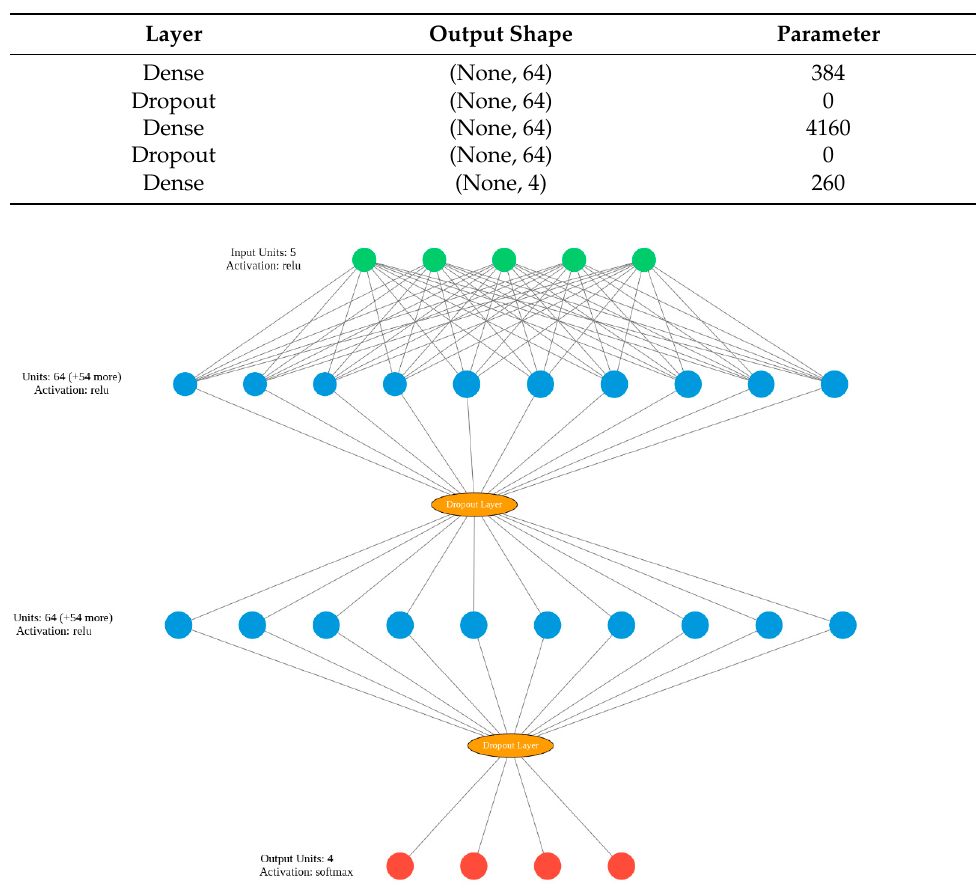
Figure 6. DNN architecture for defect diagnosis.